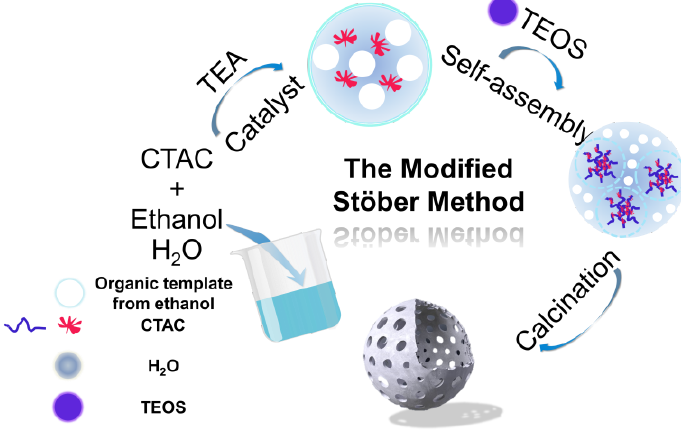
Figure 2. Synthesis mechanism of mesoporous silica nanoparticles (MSNs).